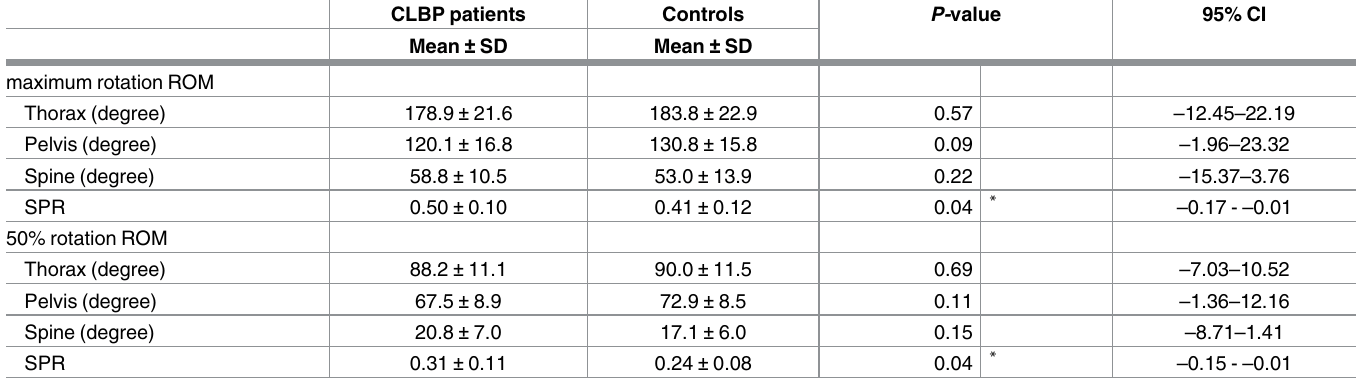
Table 3. The rotational ROM and SPR in